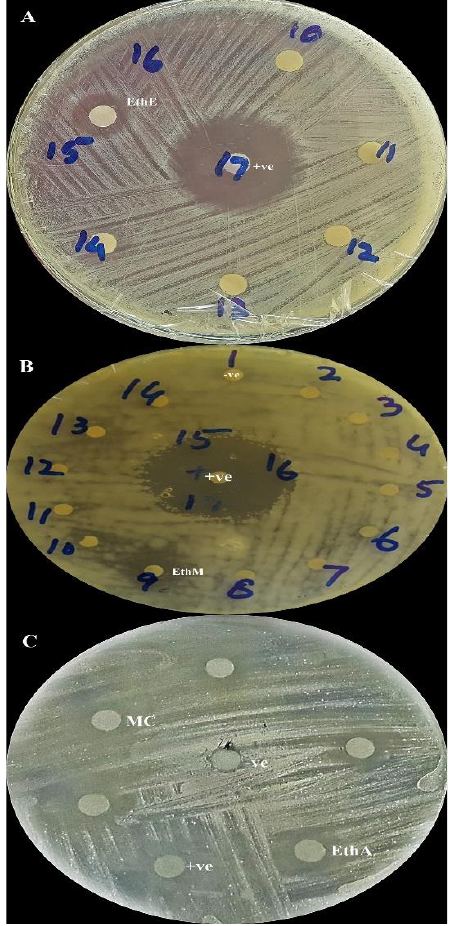
Figure 5. Antibacterial ( A ), antifungal ( B ), and protein kinase inhibition ( C ) representation of selected test samples and controls. EthE = ethyl acetate − ethanol, EthM = ethyl acetate − methanol, EthA = ethyl acetate – acetone, and MC = methanol – chloroform extracts, respectively.